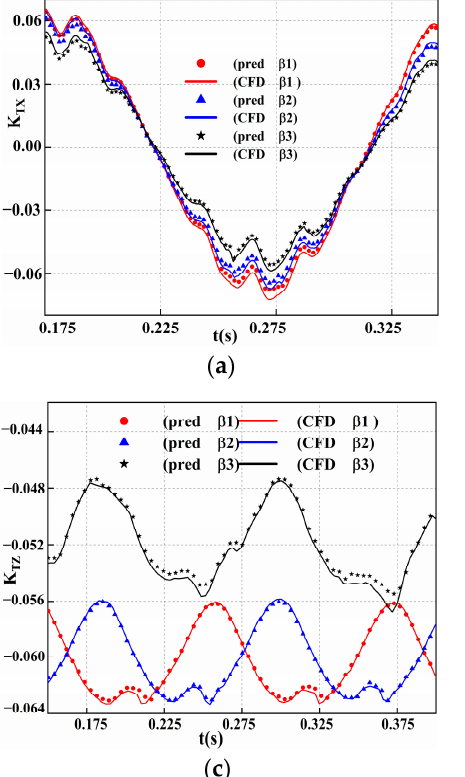
Figure 18. Pressure cloud of the rotor domain under different oblique angles and cavitation num- bers. (Top: °= 0 β , Center: °= 10 β , Below: °= 20 β ).